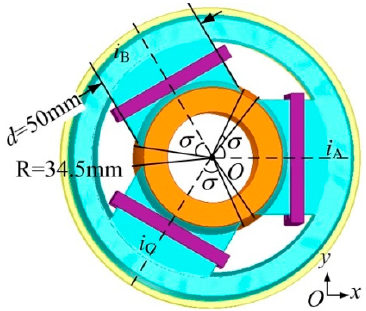
Figure 3. Calculation of geometric angle of stator.